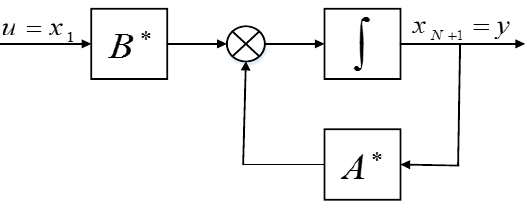
Figure 2. State-space representation of operator [19].